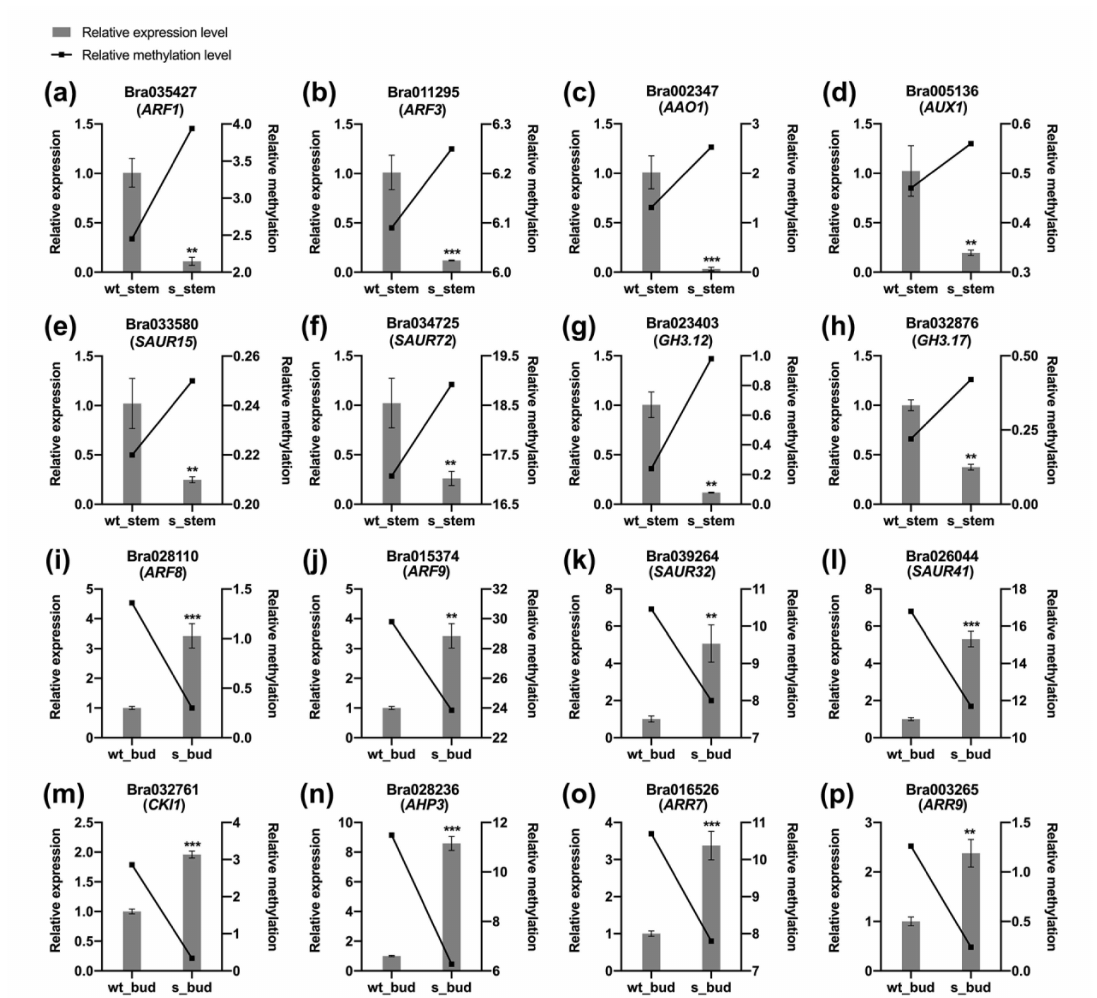
Figure 6. Relationship between the expression level and methylation level of DMGs. ( a – h ) The qRT-PCR (quantitative real-time PCR) analysis of eight auxin-related DMGs in the stems from wild- type and transgenic plants. ( i – p ) The qRT-PCR analysis of eight auxin- and cytokinin-related DMGs in the buds from wild-type and transgenic plants. The 2 − ∆∆ Ct method was used to calculate the relative expression levels of genes. Error bars indicate the means of three replicates ± SD. Significant differences are determined by Student’s t -test (** p < 0.01; *** p < 0.001). Relative expression was set on the left Y-axis with grey columns and relative methylation was on the right Y-axis with black